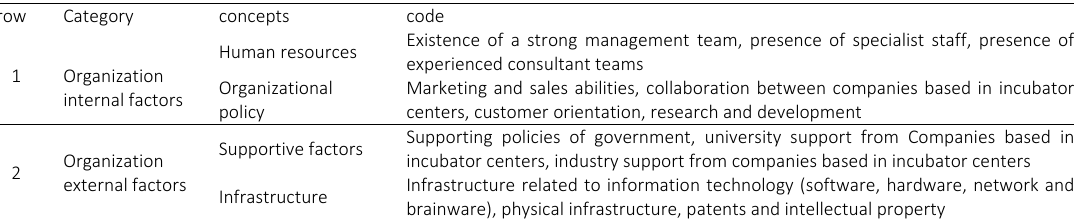
Table 2: Categorization of Findings Fig. 2: Search results and selection of appropriate articles